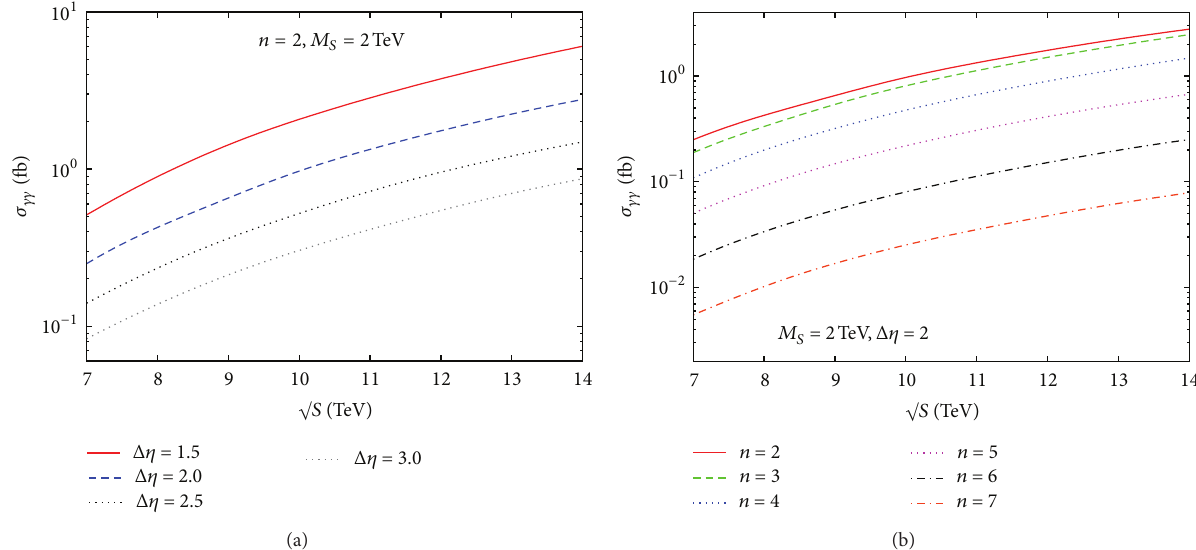
Figure 10: The total signal cross-sections ( 𝑝𝑝 → 𝑋 + 𝛾𝛾 + 𝑌 ) in diphoton channel ( 𝜎 𝑙𝑙 ) as a function of LHC CM energy. In (a), we plot 𝜎 𝑙𝑙 for Δ𝜂 = 1.5, 2.0, 2.5, and 3.0 for 𝑛 = 2 and 𝑀 𝑆 = 2 TeV. In (b), we plot 𝜎 𝑙𝑙 for 𝑛 = 2 – 7 for 𝑀 𝑆 = 2 TeV and Δ𝜂 = 2 . In both plots, 𝜎 𝑙𝑙 ’s are computed after applying the cut defined in (17).